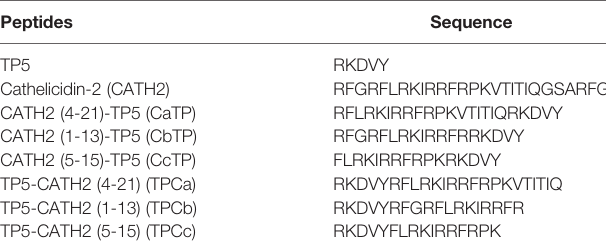
TABLE 1 | Design and sequences of the peptides.